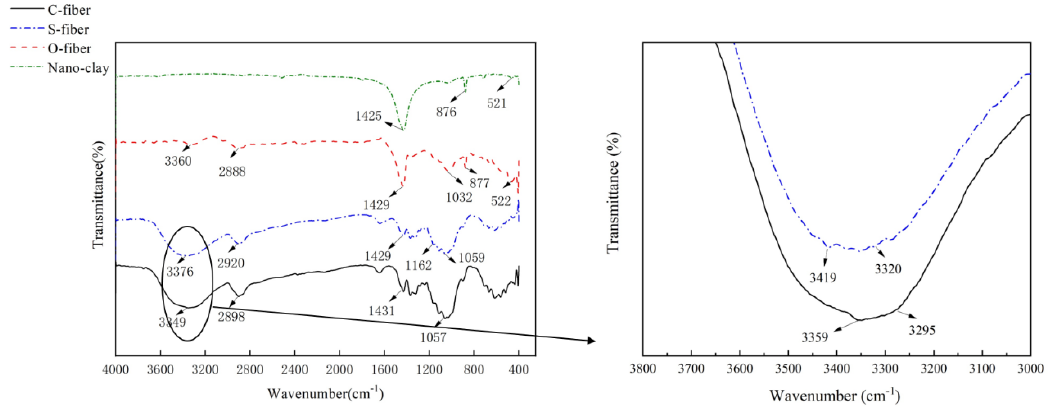
Figure 6. FTIR test results of flax fiber (C-fiber: untreated fiber; S-fiber: silane treated fiber; O-fiber: nano-clay grafted fiber) [24].